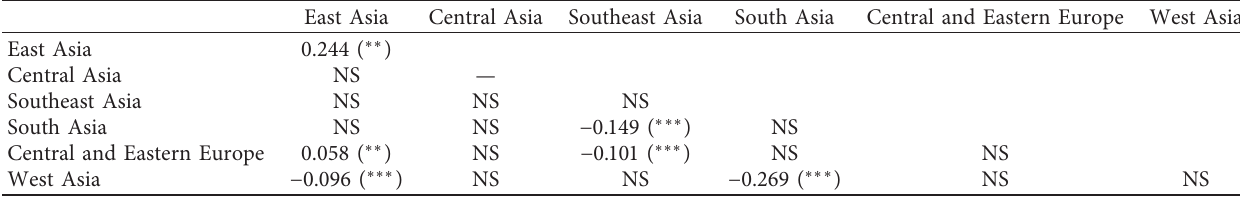
Table 6: Results of OLS regression analysis of the ID within and between subregions.